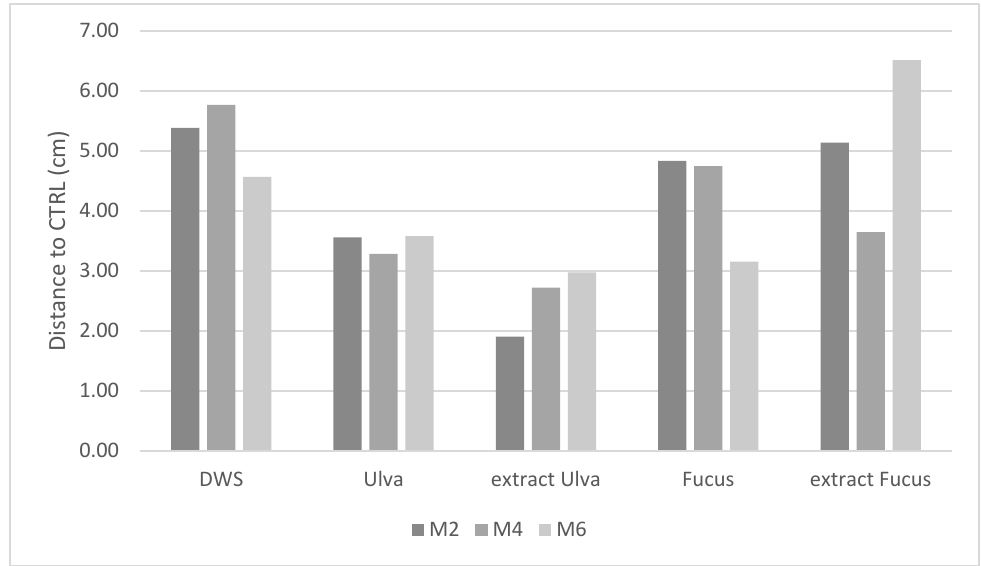
Figure 4. Difference to control between the pastas assessed over time (M2: month2; M4: month 4; M6: month 6) at each environmental condition studied.